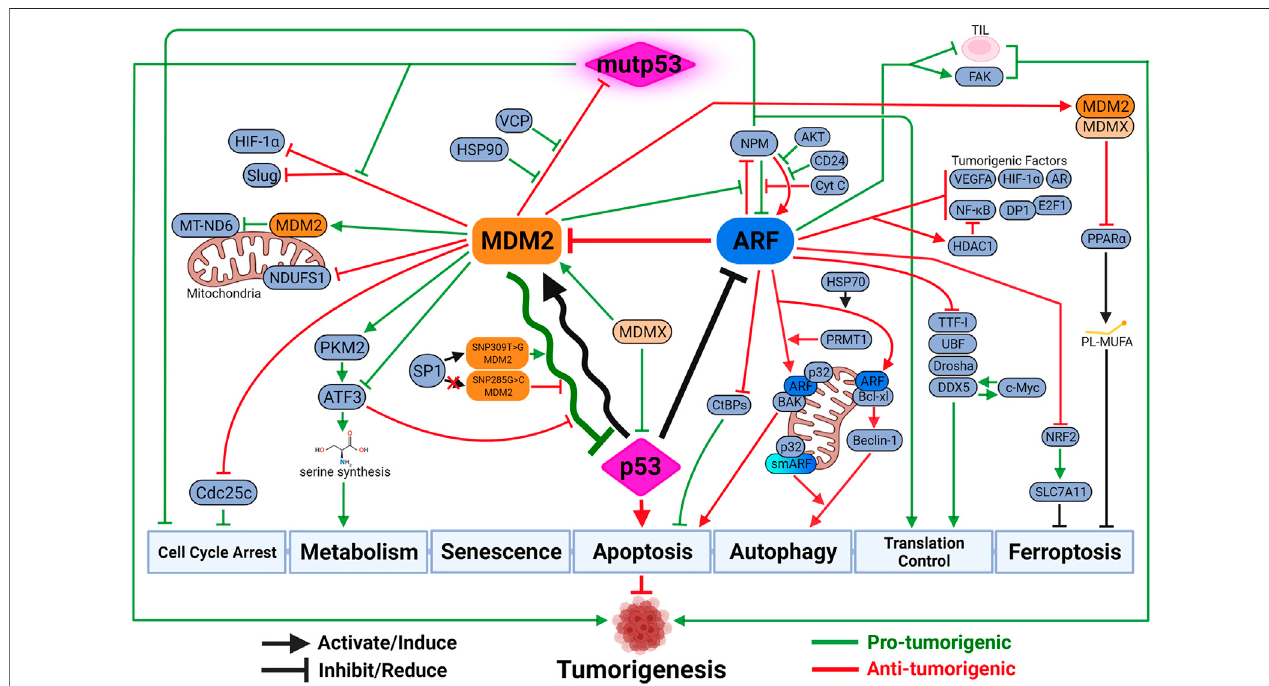
FIGURE3| The updated look at the p53-MDM2-ARF functional complex. Both MDM2 and ARF mediate a variety of p53-independent functions to regulate tumorigenesis. These functions can be either synergistic with or antagonizingagainst p53-medaited tumor-suppressive activities. Due to the negativefeedback loop, the oscillatory relationship between MDM2 and p53 dictates the intensity and duration of p53-mediated tumor-suppressive activities. The outcome of the oscillation depends on their respective expression and activity levels, which are in fl uenced by genetic alterations such as SNP and mutations. Paradoxically, MDM2 sometimes exhibits anti-tumorigenic activity by inhibiting mutant p53 (mutp53) functions, inhibiting pro-tumorigenic factors upon p53 activation, or inducing other tumor-suppressive mechanisms like ferroptosis. ARF also possesses tumor-promoting capabilities when protecting cancer cells against speci fi c types of cell death like anoikis, or exhausting functions of tumor-in fi ltrating lymphocytes (TIL) to promote cancer progression. Created with BioRender.com.